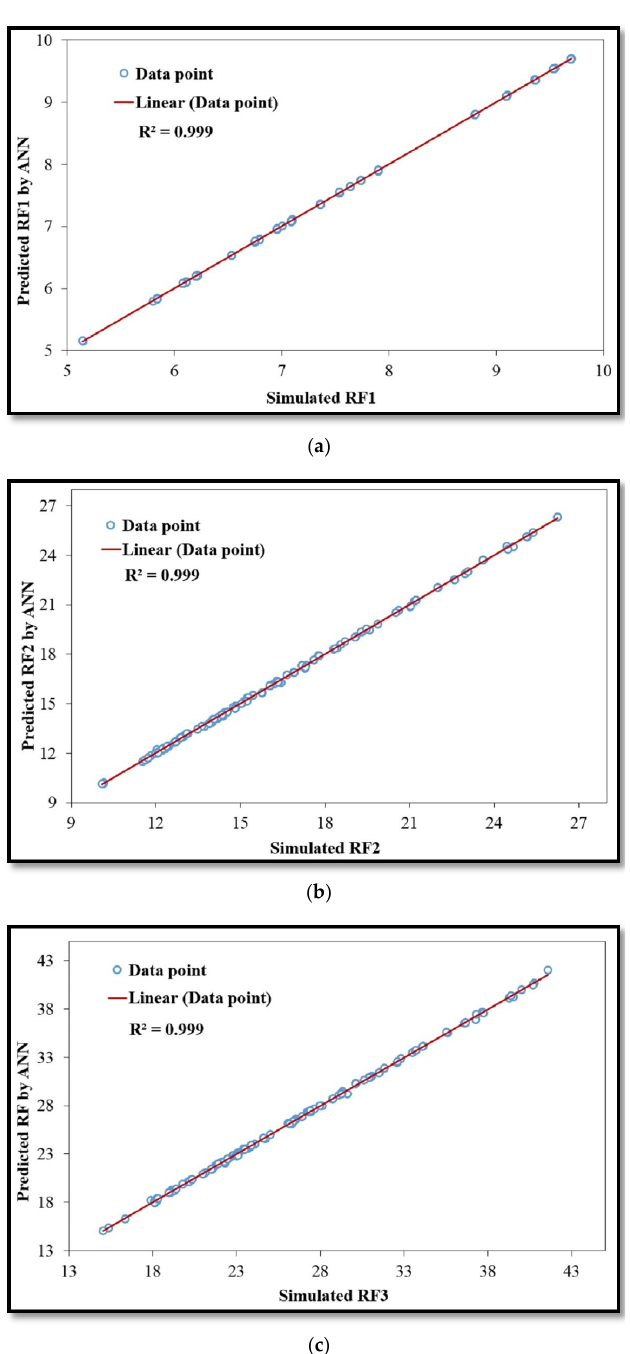
Figure A4. Illustration of the correlation coefficient for the predicted data against the simulated data during the testing process for ( a ) RF 1 , ( b ) RF 2 , and ( c ) RF 3 .